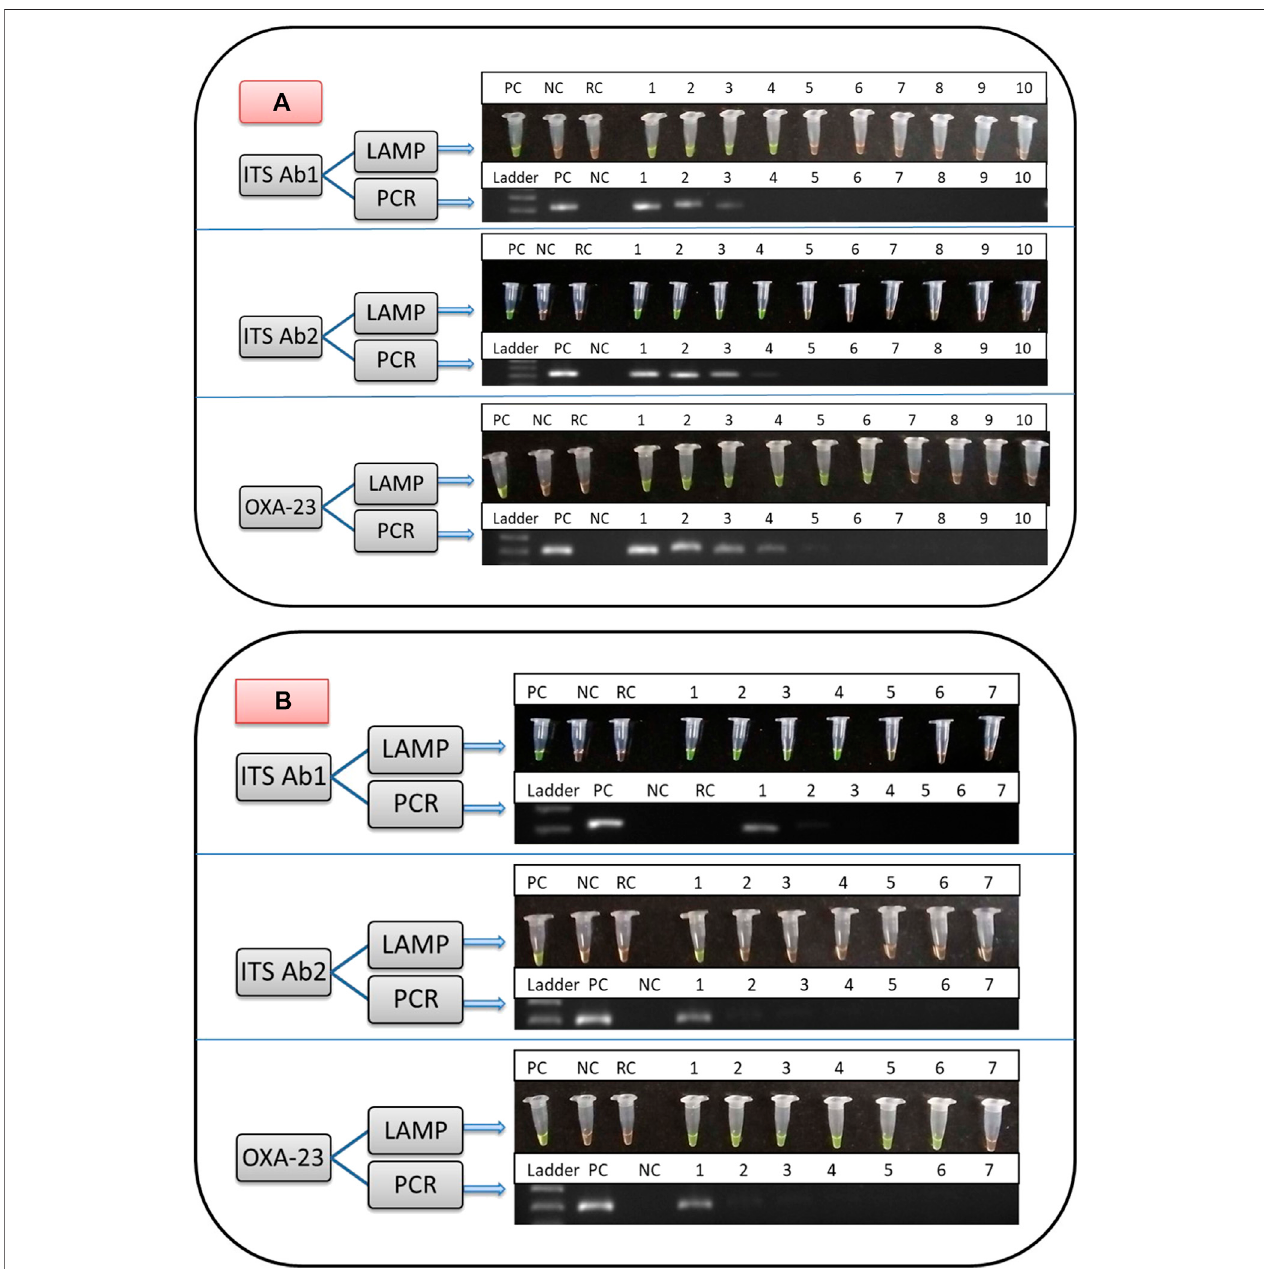
FIGURE 4 | Comparison of the limit of detection (LOD) of LAMP and PCR assays from direct culture for identi fi cation of signi fi cant members of the ACB complex using ITS Ab1 and Ab2 primers and detection of carbapenem resistance using the OXA-23 primer. (A) shows the LOD using different DNA concentrations. Lane for LAMP and PCR:PC,positivecontrol; NC,negative control;RC,reagentcontrol;DNAconcentration(/ μ l)fromLanes 1to10;100,10,1 ng, 100,10,1 pg, 100 fg,10 fg, 1 fg, and 0.1 fg, respectively. (B) shows the LOD using different colony counts. Lane for LAMP and PCR: PC, positive control; NC, negative control; RC, reagent control; colony count (cfu/ml) from Lanes 1 to 7: 1.0 × 108, 107, 106, 105, 104, 103, and 102, respectively. In (A , B) , in the LAMP assay, green and orange colors are indicative of positive and negative results, respectively, and in the PCR assay, the presence and absence of bands are indicative of positive and negative results,